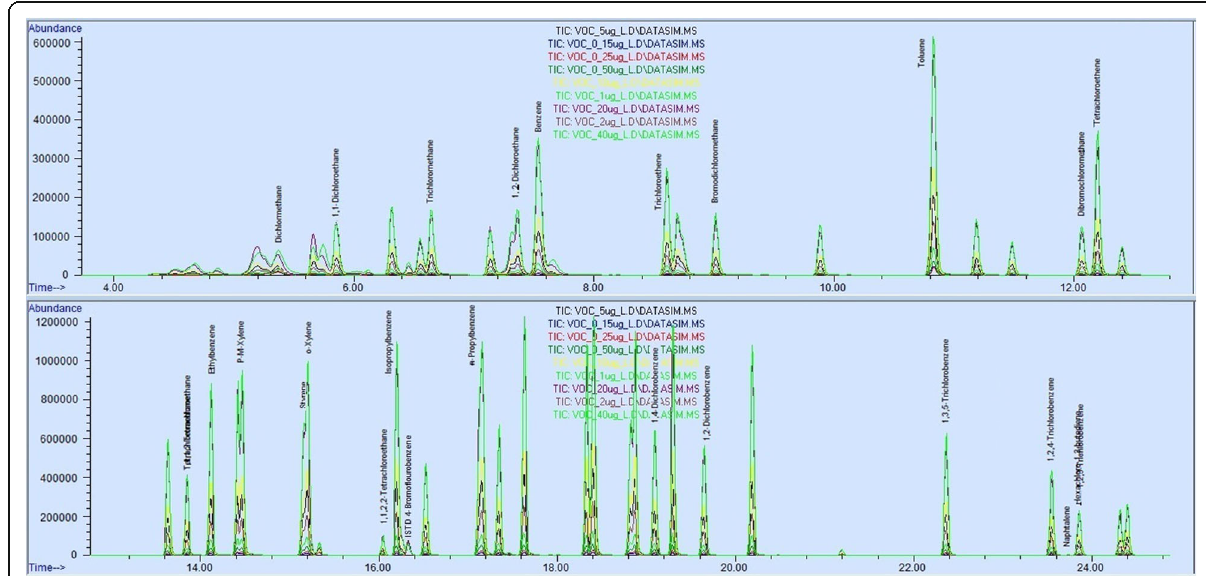
Fig. 2 Overlaid chromatograms at nine concentration levels for each